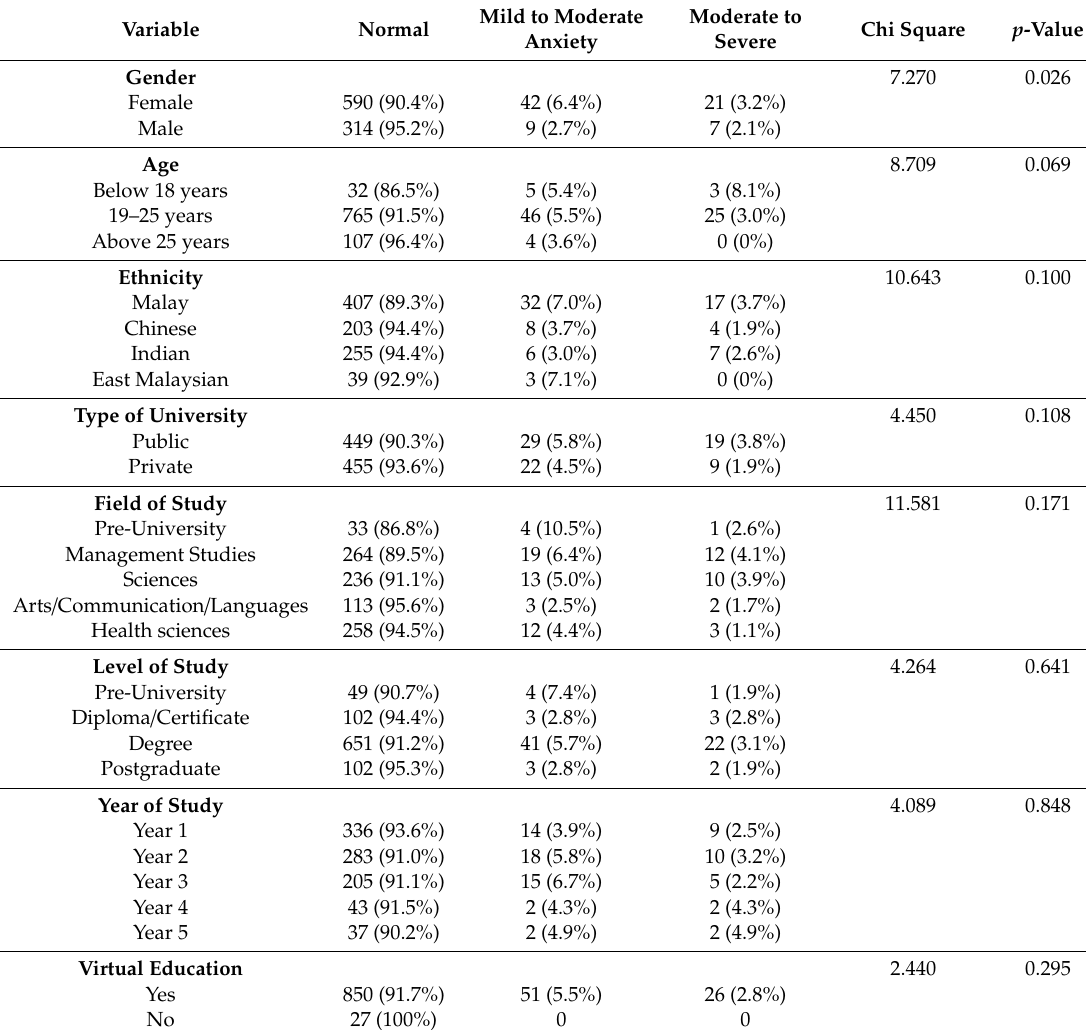
Table 3. Results from univariate